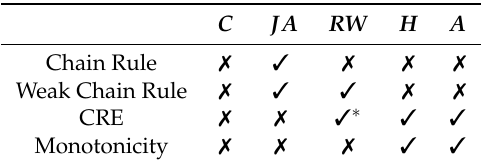
Table 1. Properties of different CRE-s ( (cid:51) stands for satisfied, (cid:55) for not satisfied, and (cid:51) ∗ for satisfied for α ≥